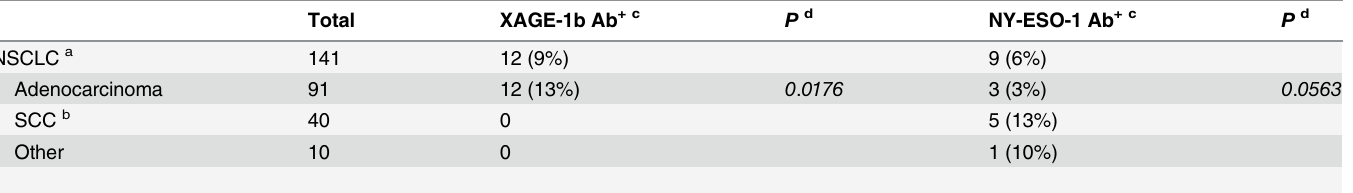
Table 2. Serological responses to XAGE-1b and NY-ESO-1 in relation to NSCLC histological